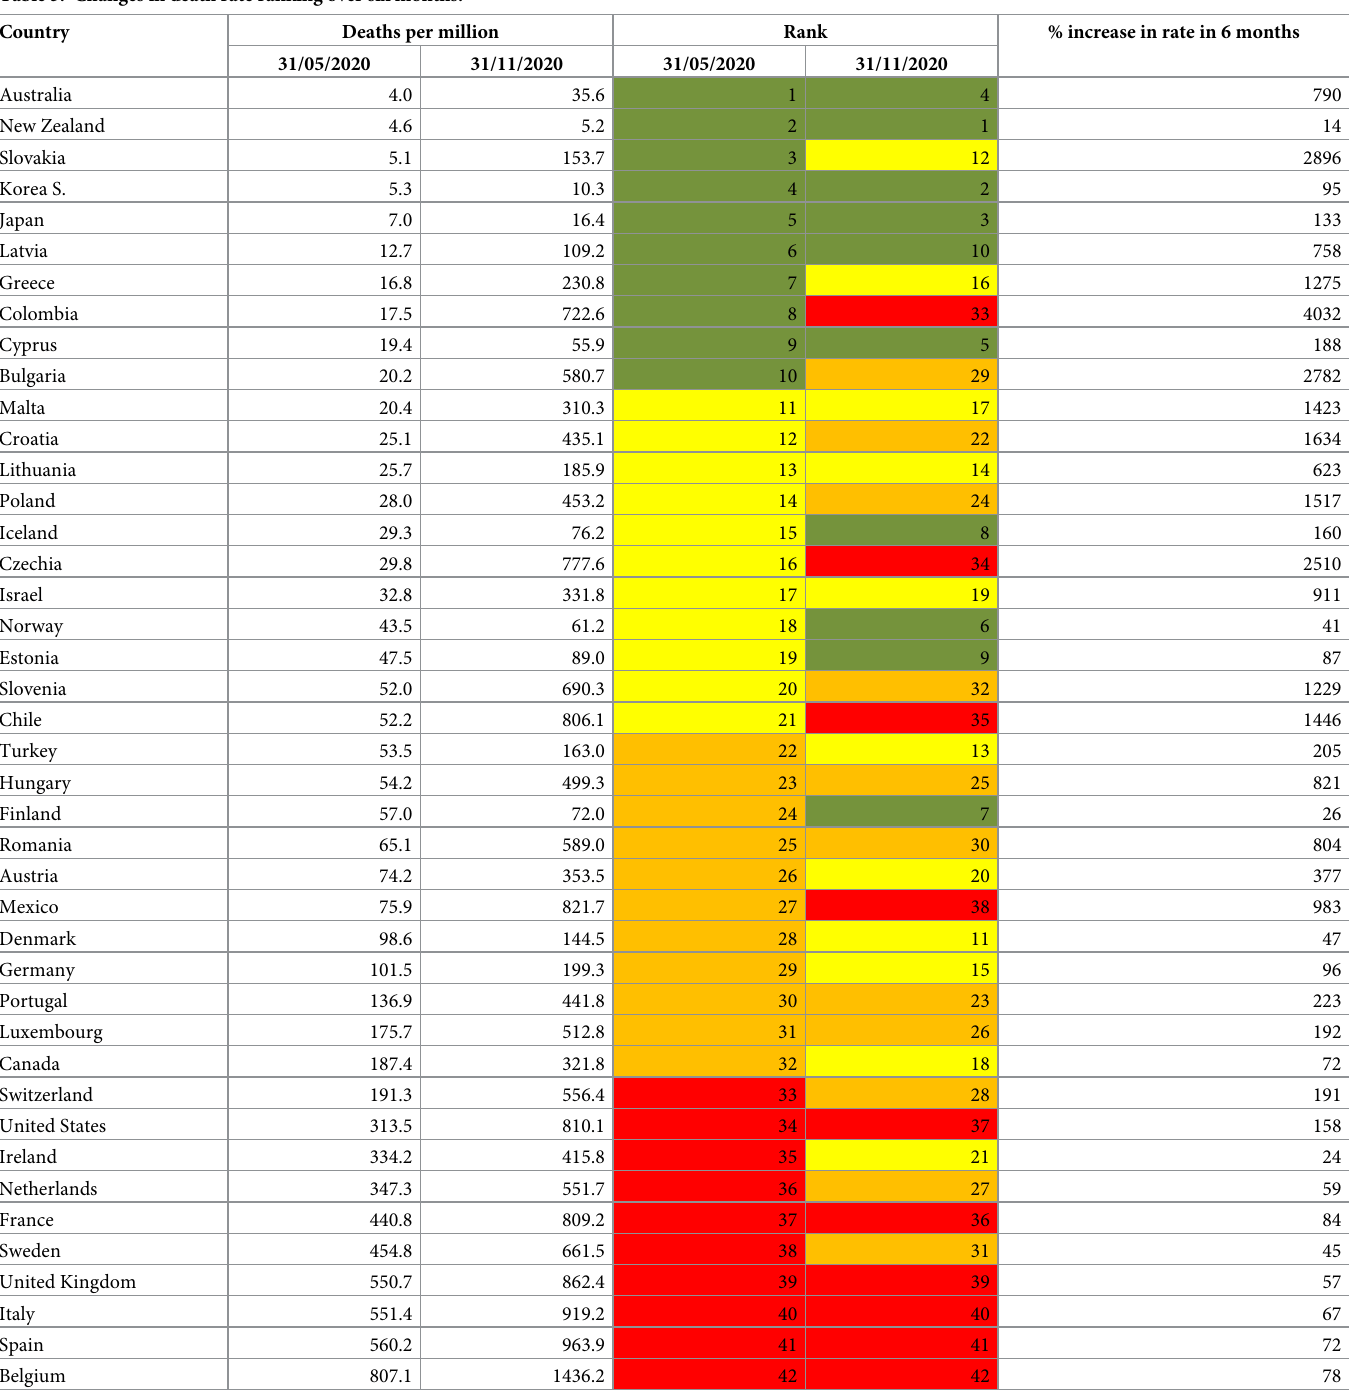
Table 3. Changes in death rate ranking over six